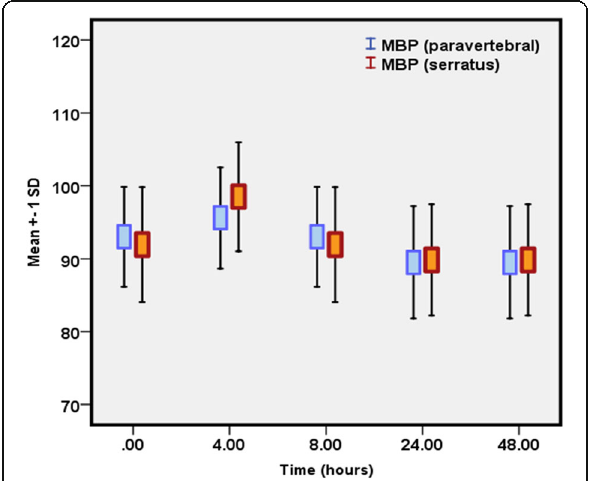
Fig. 2 Mean blood pressure (MBP) in mmHg in both